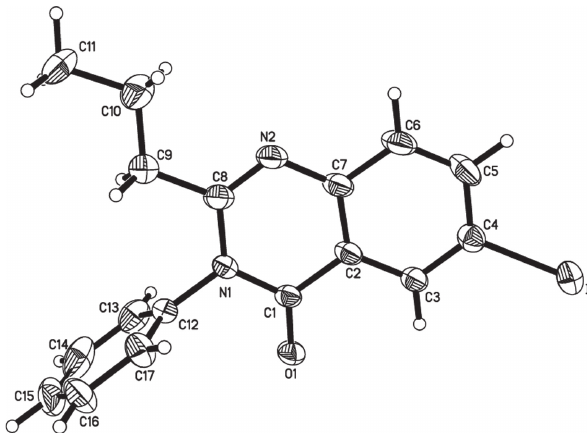
Table 2: Fractional atomic coordinates and isotropic or